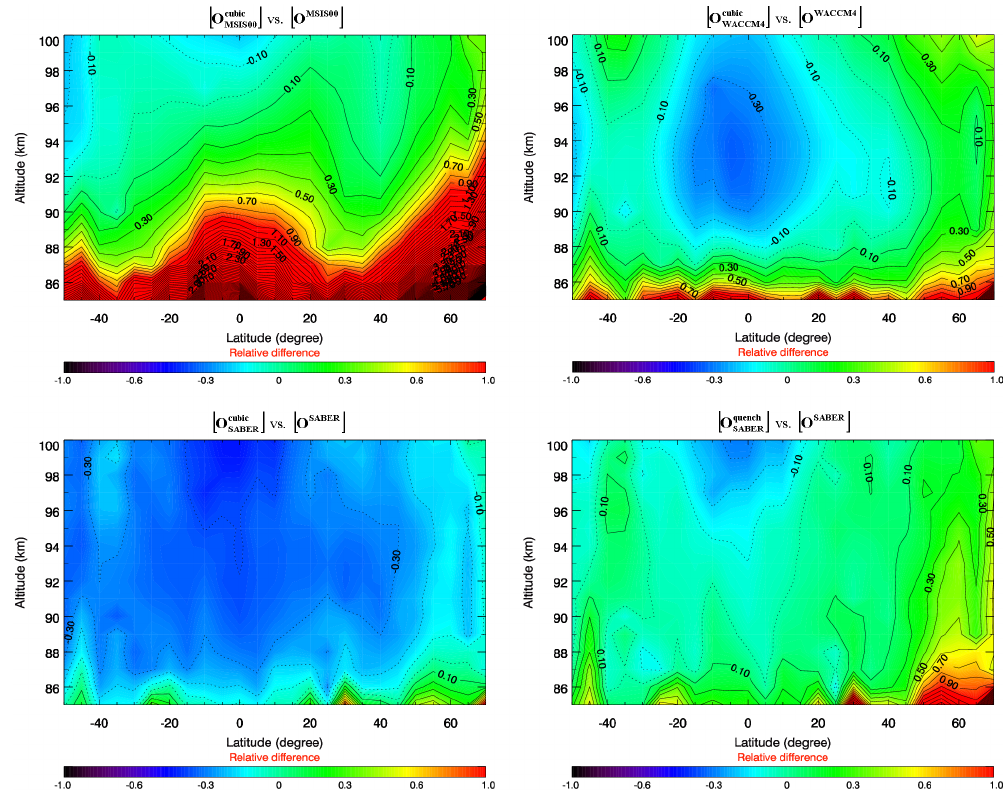
Figure 12. Relative differences in monthly averaged atomic oxygen fields from April 2010 to March 2011: [O cubic reference [O MSIS00 ] (top left), [O cubic ] compared with reference [O WACCM4 ] (top right), [O cubic WACCM4 (bottom left) and [O quench ] compared with reference [O SABER ] (bottom SABER